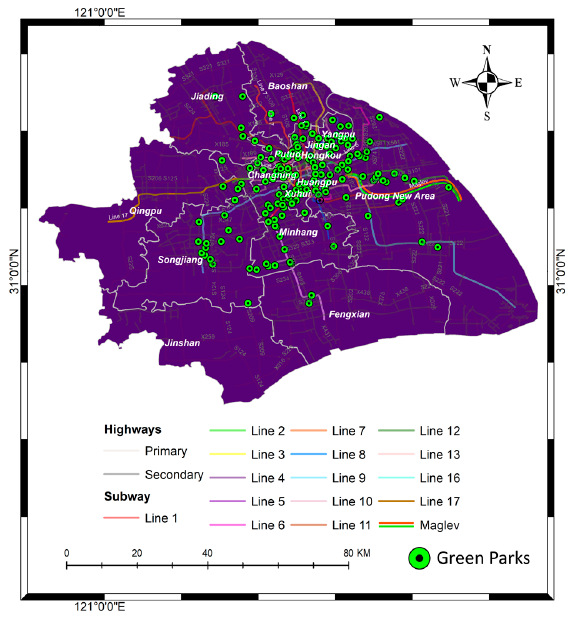
Figure 4. Parks’ distribution in Shanghai.